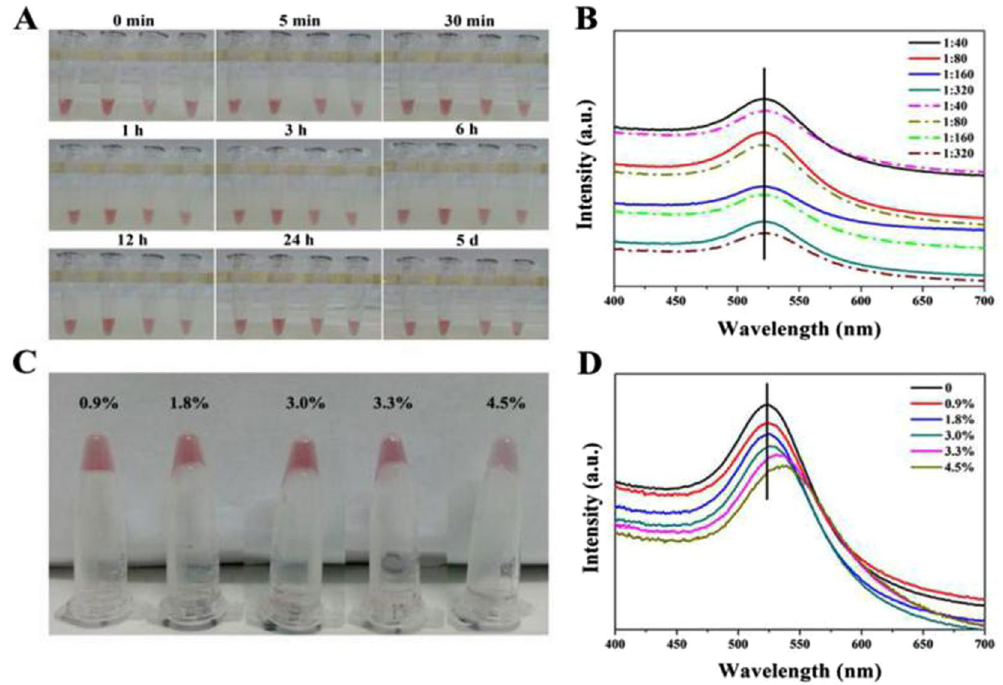
Figure 4. Stability evaluation of the PEG-CSAuNAs prepared at different molar ratios of core-AuNPs-ssDNA to satellite-AuNPs-ssDNAc in different NaCl solutions. ( A ) Digital photos of the PEG-CSAuNAs prepared at the 1:40, 1:80, 1:160 and 1:320 molar ratios (from left to right) after incubation with normal saline for different time. ( B ) UV-vis spectra of PEG-CSAuNAs prepared at the 1:40, 1:80, 1:160 and 1:320 molar ratios before (solid line) and after (dash line) incubation with normal saline for 5 days. ( C ) Digital photos and ( D ) UV-vis spectra of the PEG-CSAuNAs prepared at the 1:160 molar ratio in different NaCl concentrations for 2 h.